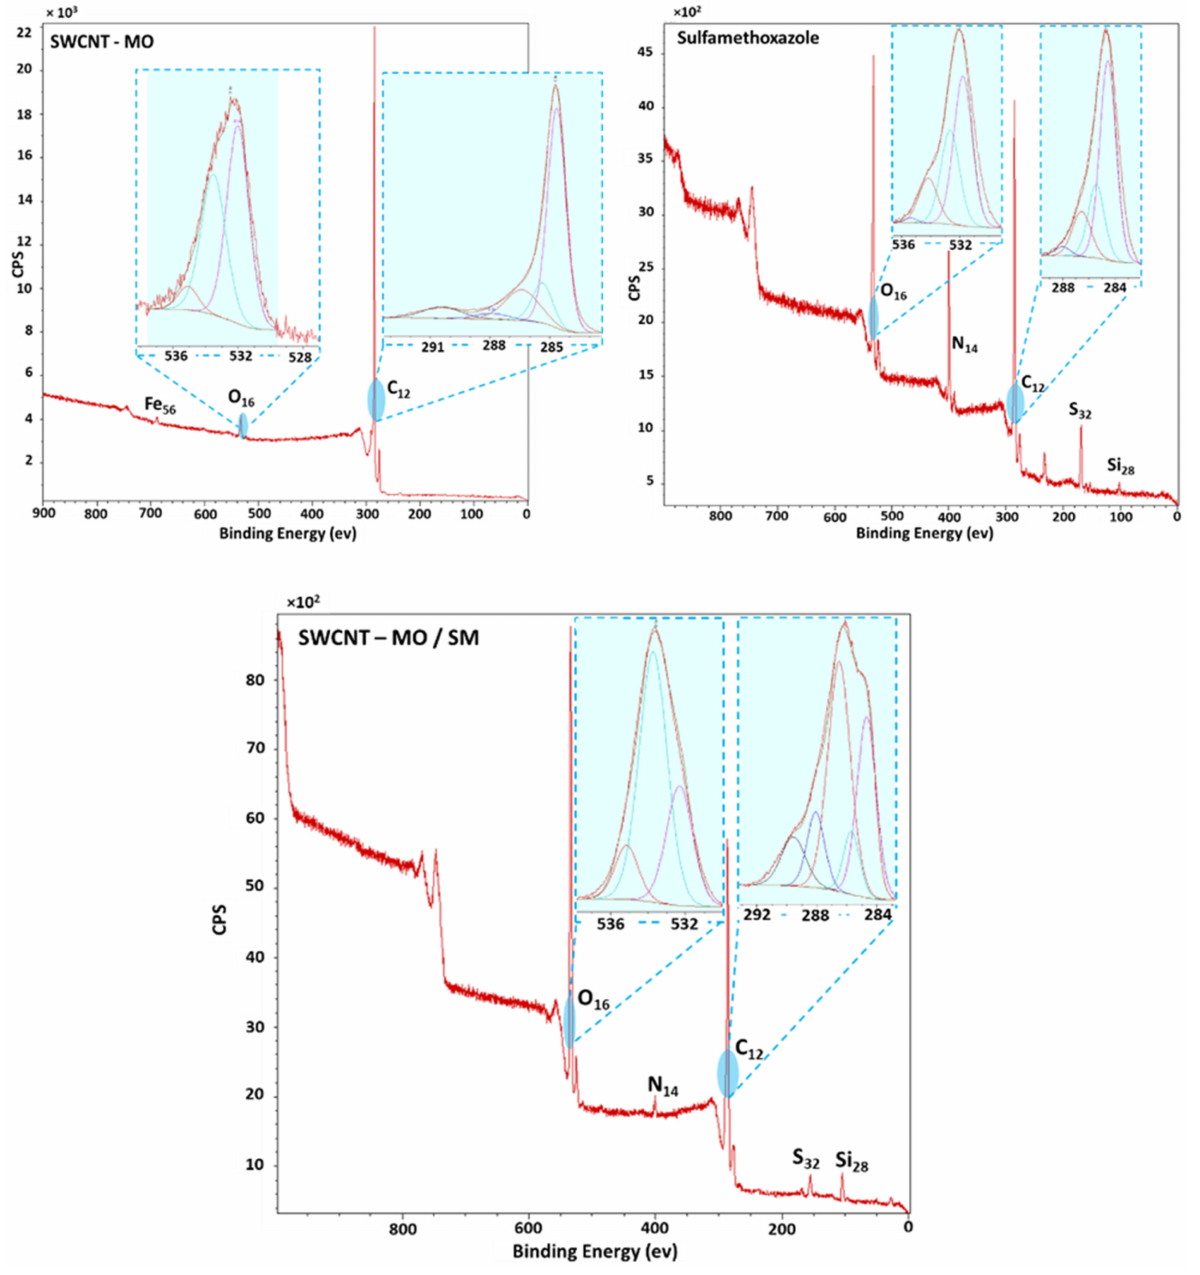
Figure 16. XPS spectra of the fresh and the used membrane SWCNT-MO-200 for SM